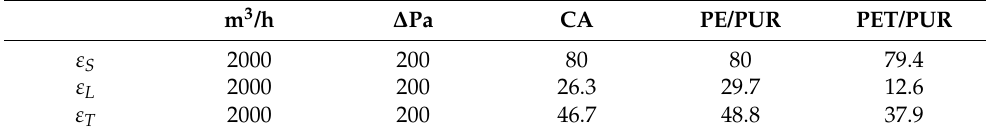
Table 7. Summarized effectiveness of the cores with a 100 µm membrane thickness under nominal conditions.